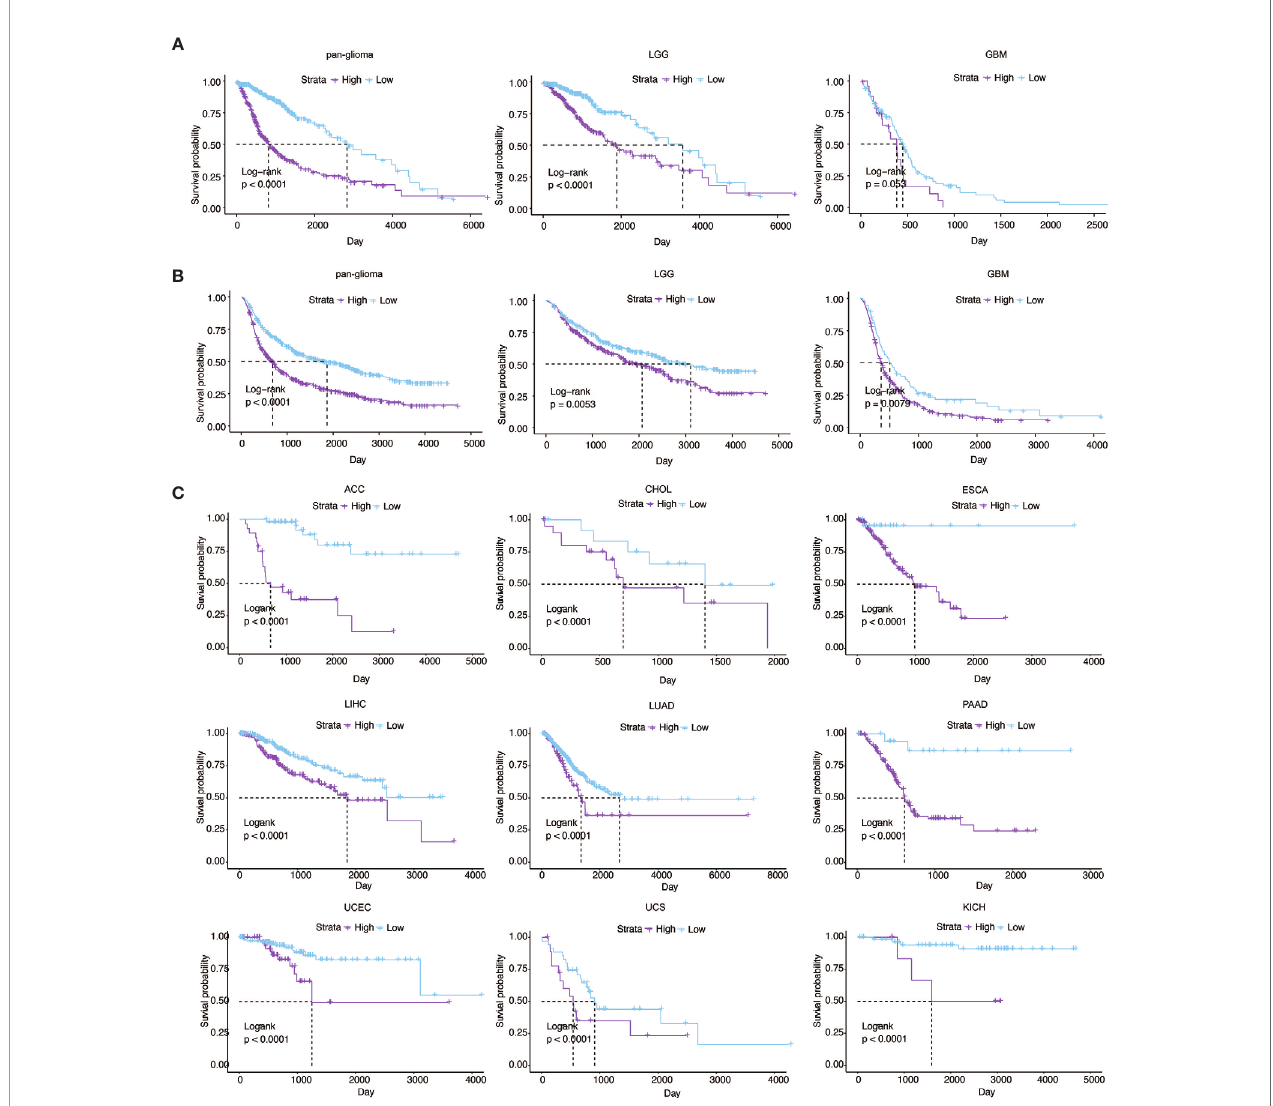
FIGURE 3 | Higher APOBEC3B expression is related to poor survival in glioma and multiple cancers. Kaplan – Meier analysis of overall survival (OS) based on high vs low expression of APOBEC3B in pan-glioma analysis, LGG, and GBM patients in (A) TCGA and (B) CGGA datasets. GBM patients were strati fi ed according to the cutpoint value automatically calculated in TCGA, and the cutpoint value was 3.1278. Kaplan – Meier analysis of overall survival (OS) based on high vs low expression of APOBEC3B in (C) ACC, CHOL, ESCA, LIHC, LUAD, PAAD, UCEC, UCS and